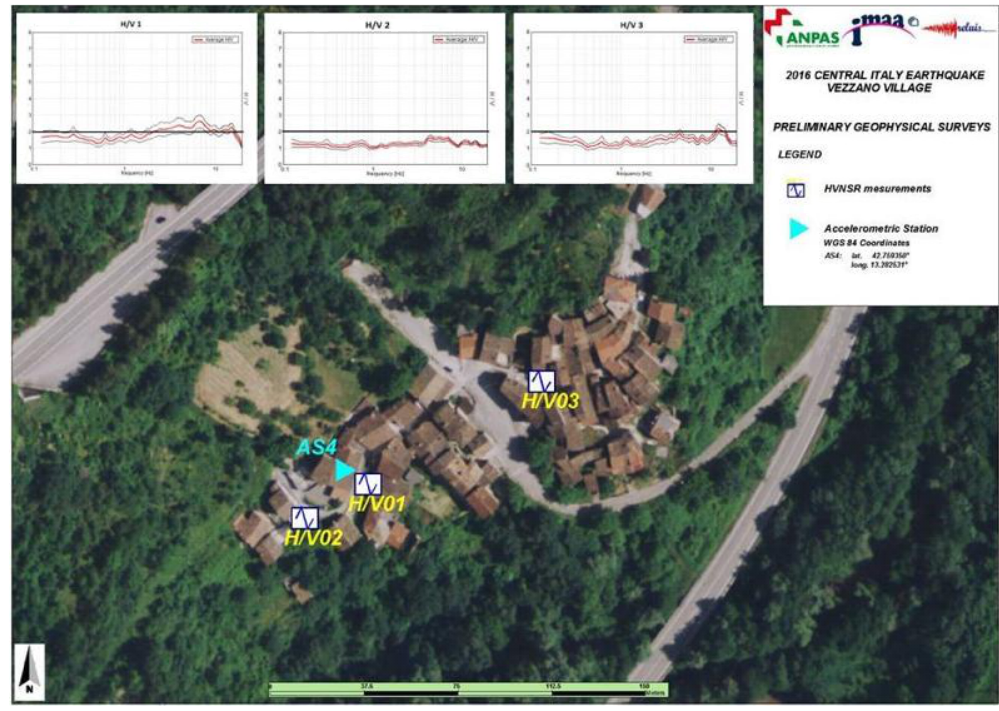
Figure 9: Ambient noise HVSR functions estimated in